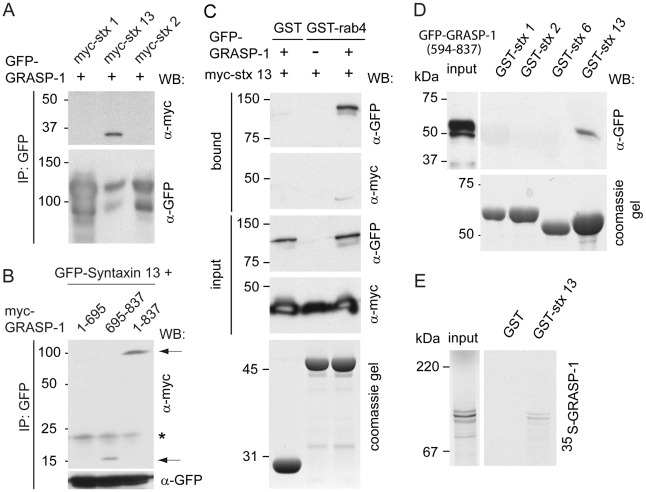
Syntaxin 13 interacts with the C-terminal domain of GRASP-1.(A) Lysates of COS-7 cells cotransfected with GFP-GRASP-1 and myc-syntaxins were immunoprecipitated with anti-GFP antibody and analyzed by Western blot. (B) Lysates of COS-7 cells cotransfected with GFP-syntaxin 13 and full-length myc-GRASP-1 (1–837) or truncated myc-GRASP-1 constructs (1–695 or 695–837) were immunoprecipitated with anti-GFP antibody and analyzed by Western blot. Asterisk indicates background band. Arrows point to co-precipitated GRASP-1 proteins. (C) Binding assay using lysates of COS-7 cells expressing myc-syntaxin 13 with or without GFP-GRASP-1 and GMP-PNP-charged GST-rab4. Note that myc-syntaxin 13 is only isolated on the beads in the presence of GRASP-1. (D) Binding assay using lysate of COS-7 cells transfected with GFP-GRASP-1(594–837) and GST-syntaxins without transmembrane domain (ΔTM). GRASP-1 was analyzed by Western blot with antibody against GFP. (E) Binding assay of 35S-labeled GRASP-1 and immobilized GST-syntaxin 13ΔTM.